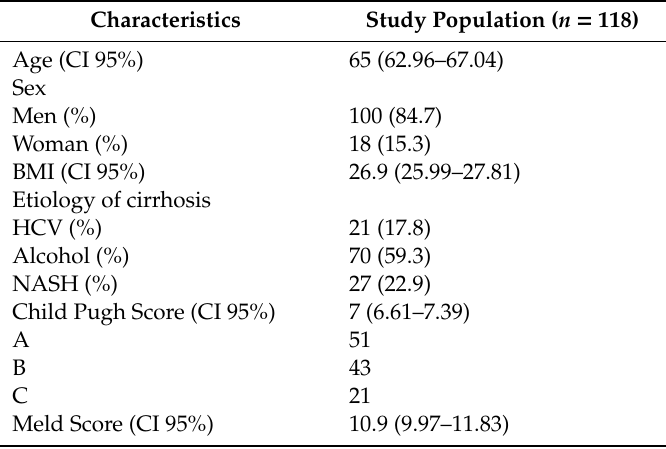
Table 2. Baseline characteristics of patient